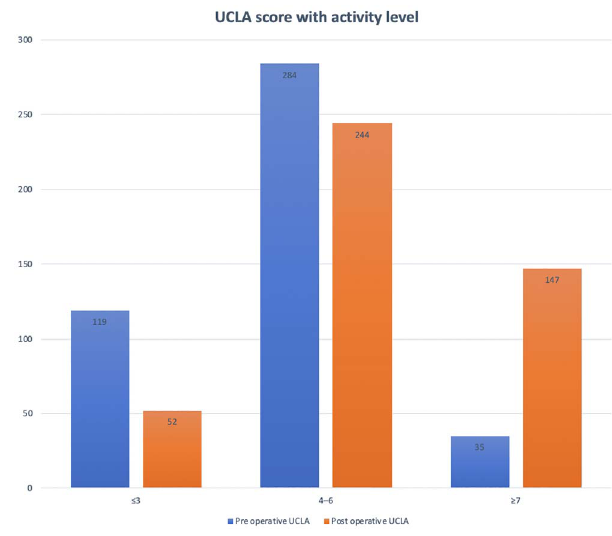
Figure 2. Pre- and post-operative UCLA score with activity level.